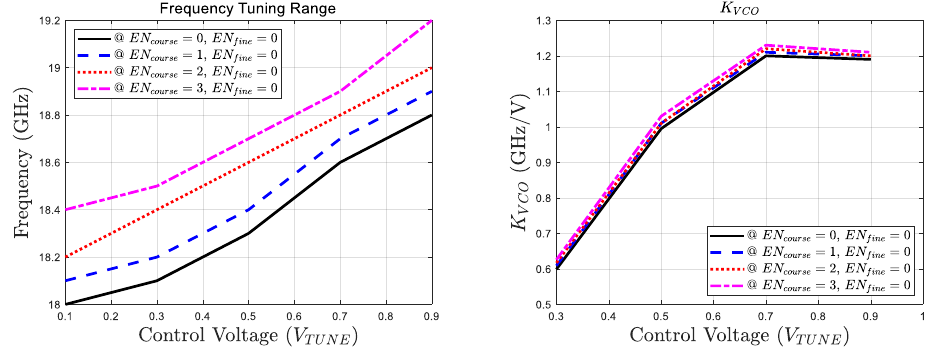
Figure 6. Simulated frequency tuning range ( left ) and 𝐾 𝑉𝐶𝑂 ( right ).